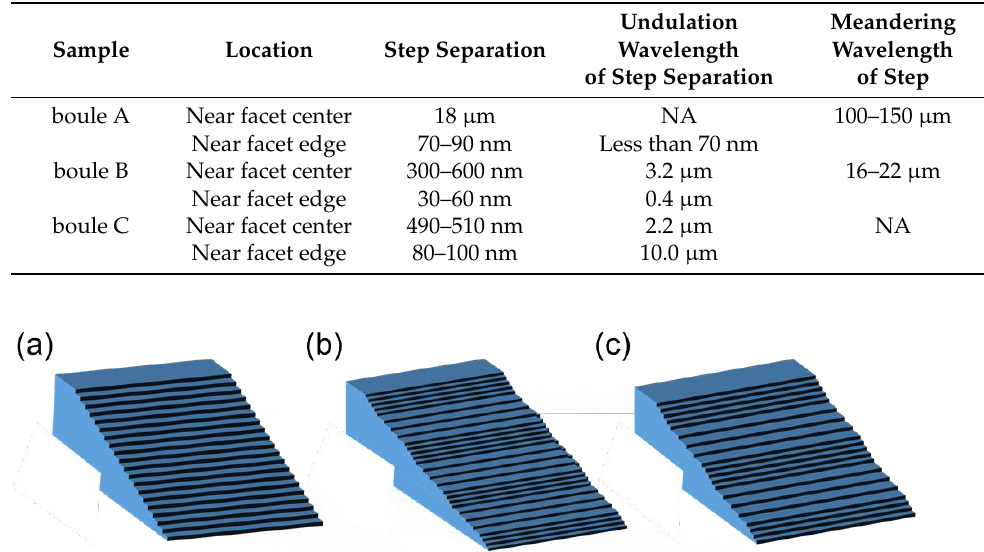
Table 1. Nitrogen doping concentration dependence of the average step separation between half-unit cell height steps and the undulation wavelength of step separation in the central and the edge Figure 2. AFM images at ( a ) Point A, ( b ) Point B, and ( c ) Point C near the edge of the (0001 regions of the (0001 ) facet, and the meandering wavelength of half-unit cell height steps in the boules A, B, and C, respectively. In each figure, ( i ) wide-area AFM image (20- μm square area), ( ii ) central region of the facet of boule A (N: mid-10 17 cm − 3 ), boule B (N: mid-10 18 cm − 3 ), and boule C small-area image (0.9- μm square area), and ( iii ) height profile are shown, where the small-area AFM (N: mid-10 19 cm − 3 ). image was taken from the area indicated by an open square in ( i ), and the height profile was taken along the blue line indicated in ( ii ).